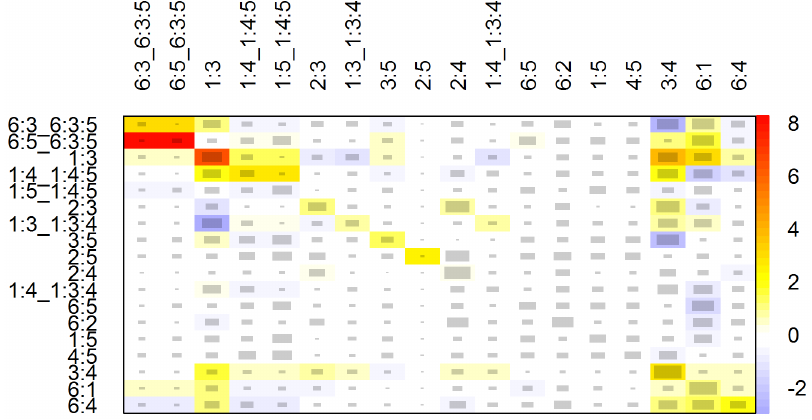
Fig. 2. Inconsistency-detecting heat map function netheat from the netmeta package applied to the diabetes data